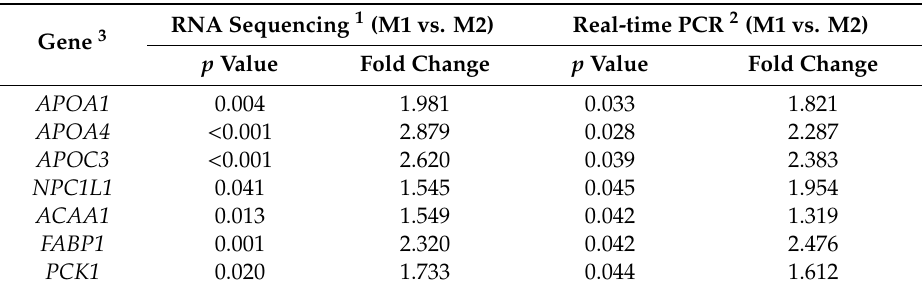
Table 5. Validation of RNA sequencing results of samples in pigs feeding one time (M1) or twice daily (M2) by real-time quantitative PCR.